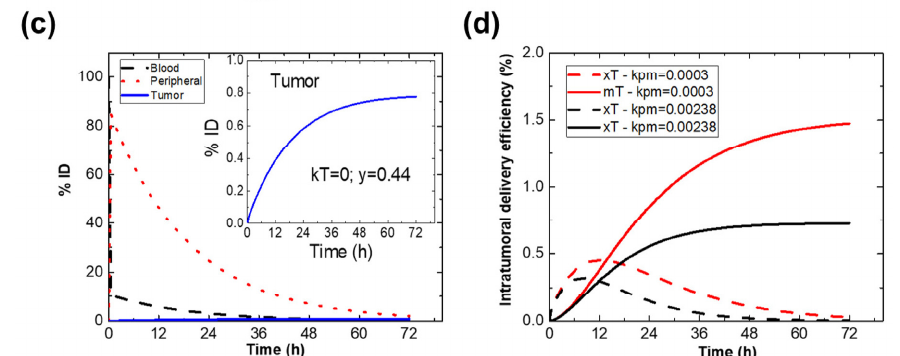
Figure 4. Simulated PK profiles for BNF-Her nanoparticles. Simulated tumor retentions of 100-nm BNF-Her nanoparticles varying several model parameters ( a ) K pb , ( b ) K out from macrophages M1, and ( d ) K pm . Dashed lines represent passive retention ( x i ), and solid-colored lines represent active retention by macrophages ( m i ). ( c ) Black, red and blue lines represent, respectively, the kinetics of NPs in the blood, peripheral and tumor compartment, in %ID, for the case without cell retention, i.e., k t = k b = k p = 0 and y = 0.44. The inset shows intratumor delivery efficiency.